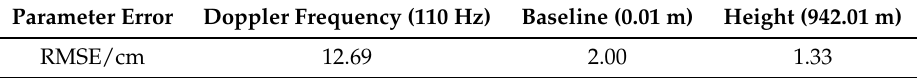
Table 4. The RMSE between the corrected DInSAR phase with different parameter errors and the corrected DInSAR phase without parameter errors in distance on 20100623 and